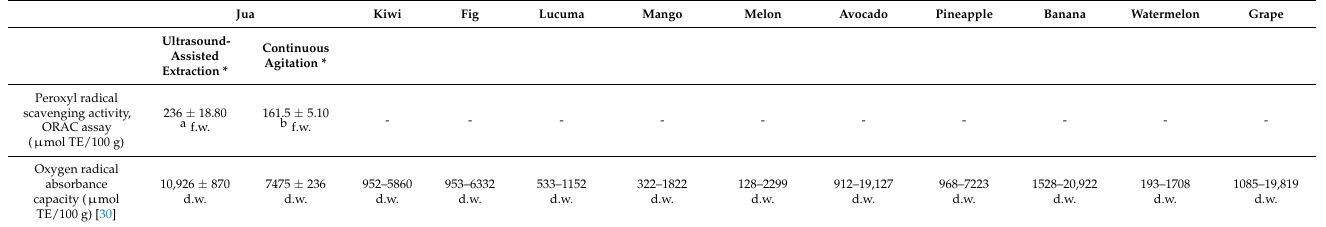
Table 3. Antiradical activity results for jua pulp extracts obtained by ultrasound-assisted extraction and continuous agitation, and oxygen radical absorbance capacity of selected fruits obtained from the literature. Fig Lucuma Mango Melon Avocado Pineapple Banana Watermelon